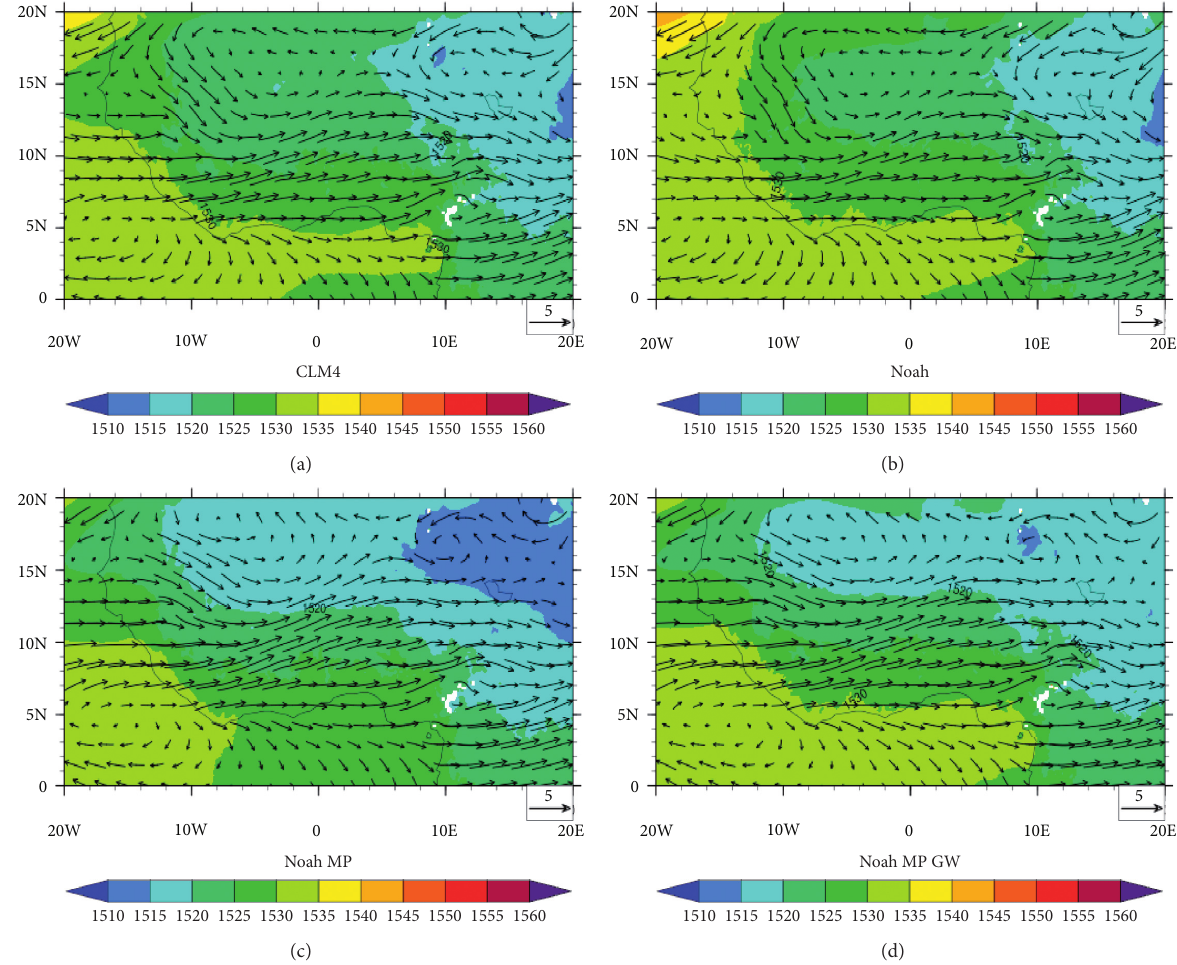
Figure 14: Mean JAS wind vectors at the 850hPa vertical height. Geopotential heights (m) are shown in colours. (a) CLM4. (b) Naoh. (c) Noah-MP. (d) Noah-MP-GW.